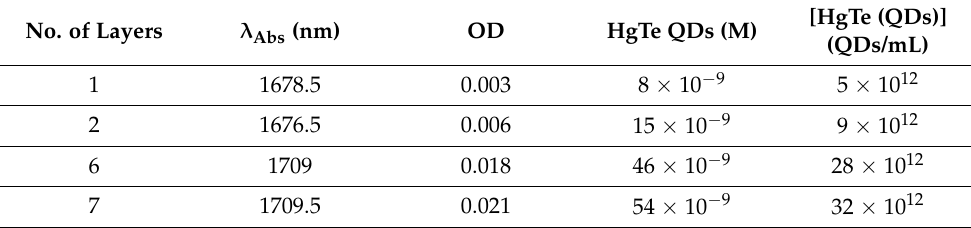
Table 2. Parameters of deposited MTQDs films. λ Abs is the wavelength of maximal absorbance in the IR range, OD is optical density of film, HgTe QDs (M) is the molar concentration, HgTe QDs (QDs/mL) is the number of QDs in 1 mL, Solvent for deposition is